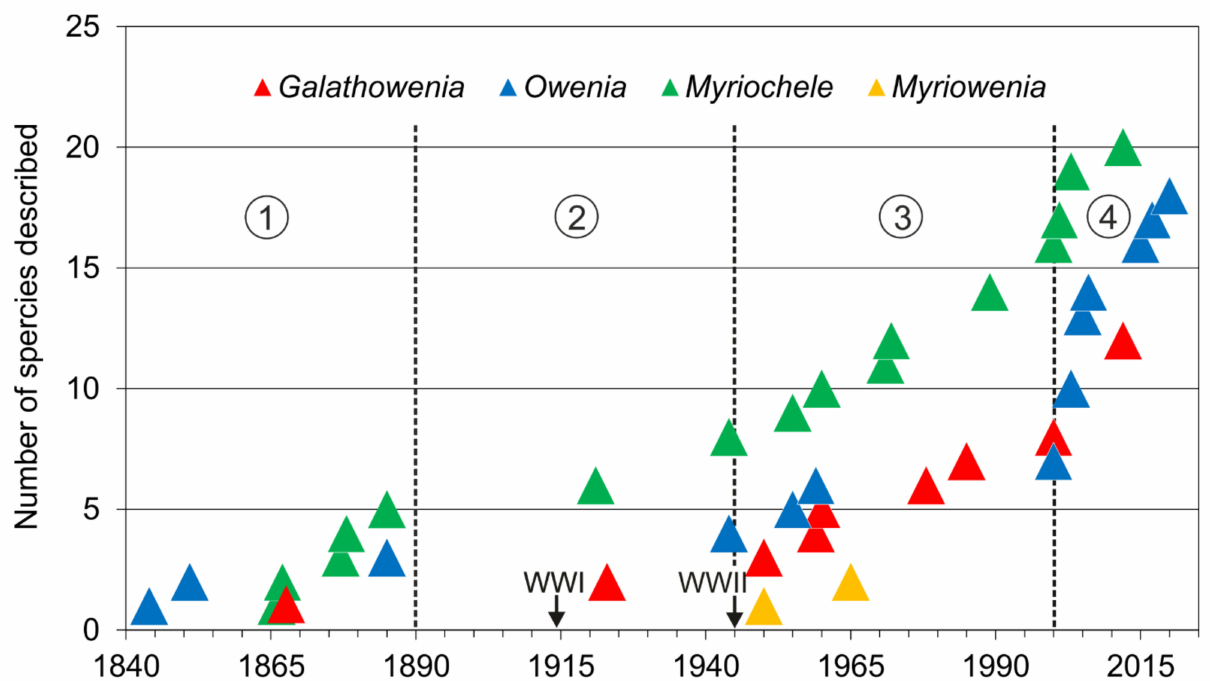
Figure 13. Number of described species (accumulated) of each oweniid genus. Encircled numbers indicate relevant historic moments (separated by discontinuous lines): ( 1 ) from first described species to 1890; ( 2 ) 1890 to the end of WWII in 1945; ( 3 ) 1945 to 2000; ( 4 ) 2000 to the